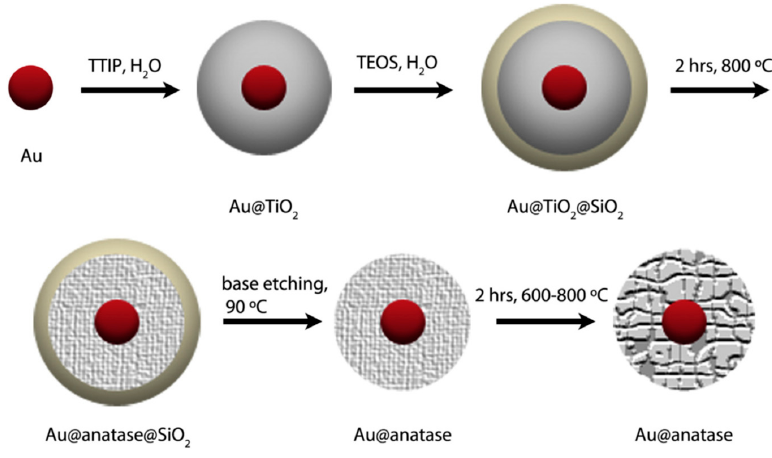
Figure 5. Scheme for preparation of Au @ TiO 2 core ‐ shell composite. (Adapted from Ref. [73]).